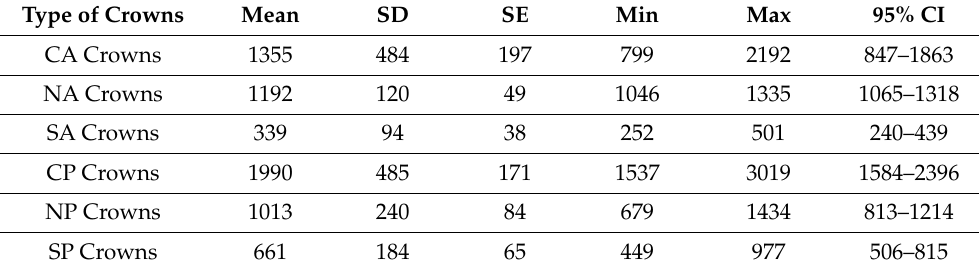
Table 1. The mean fracture resistance among primary anterior, and posterior zirconia crowns.